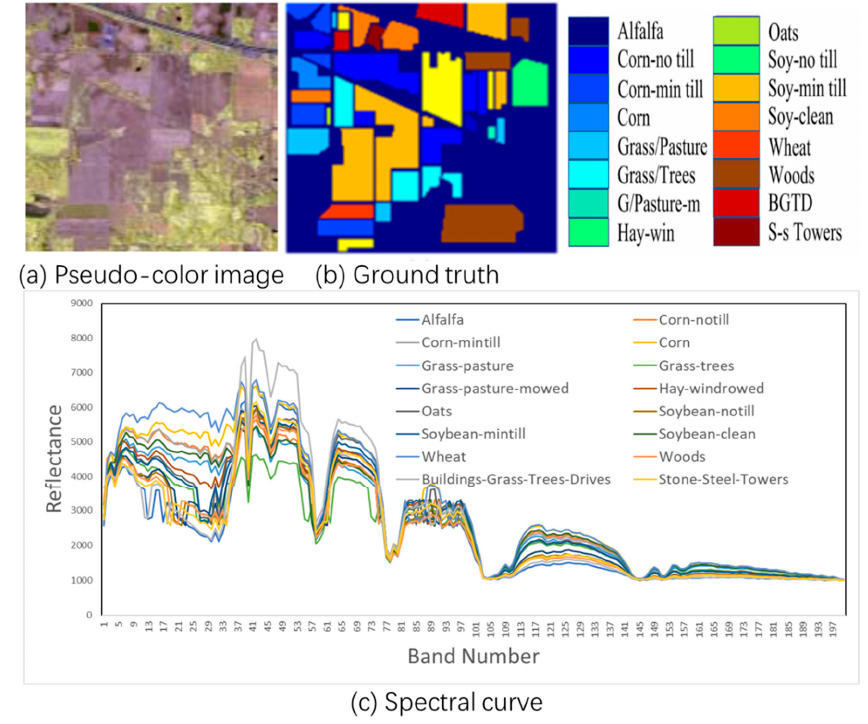
Figure 6. Indian pines dataset. (a) is pseudo-color image of Indian pines dataset. (b) is its ground truth image. (c) is the spectral curve of Indian pines dataset.